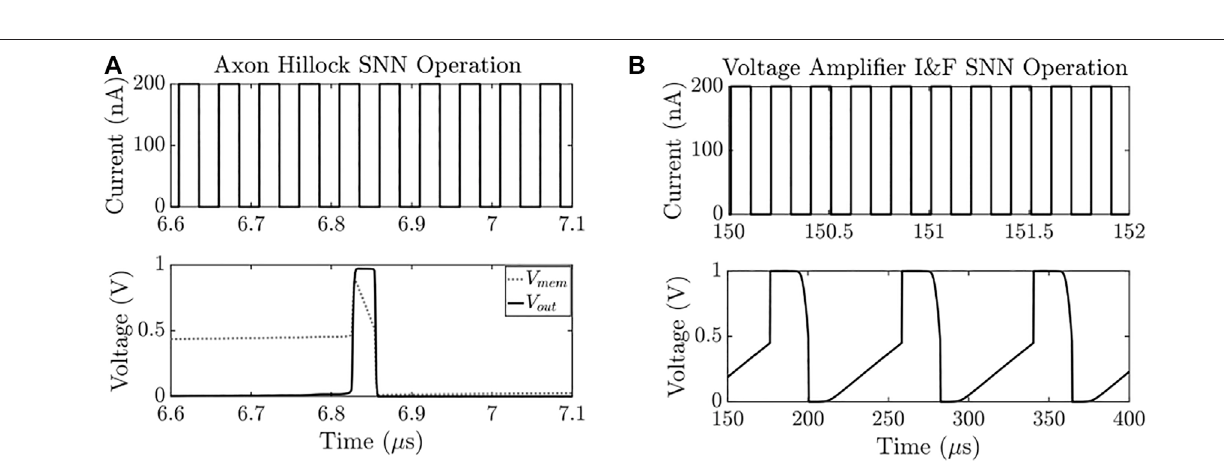
Frontiers in Nanotechnology |